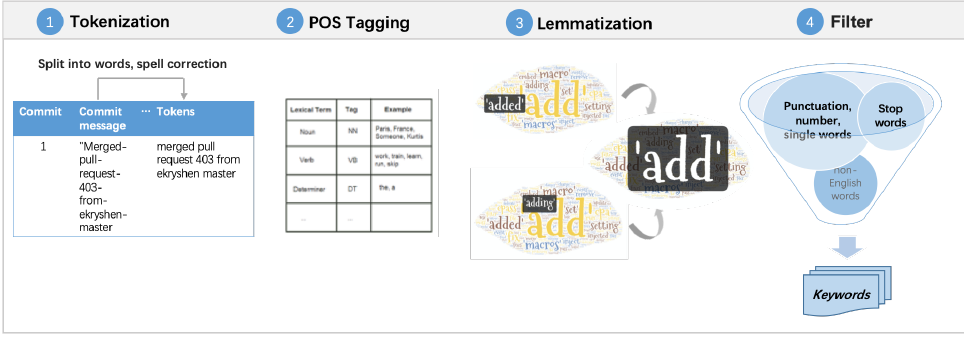
Figure 4. An example of step 2—Data preprocessing.